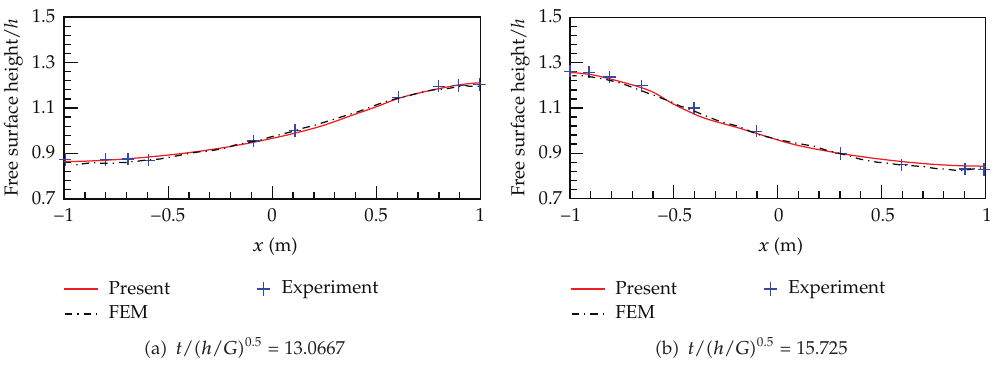
Figure 2: Distribution of free surface elevation at two times.